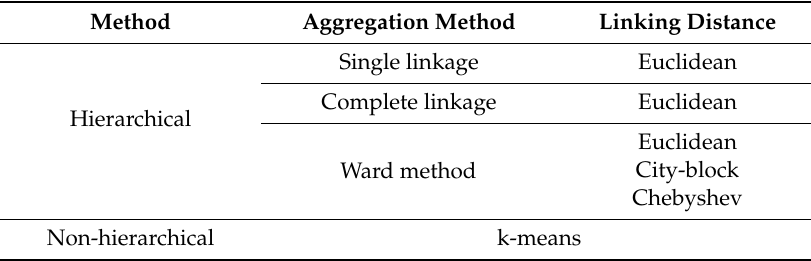
Table 4. Hierarchical and non-hierarchical methods